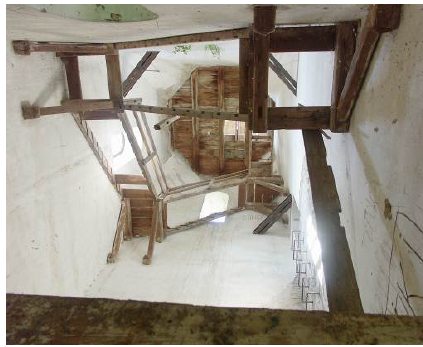
Figure 4. The photograph of the tower interior used for SVR.